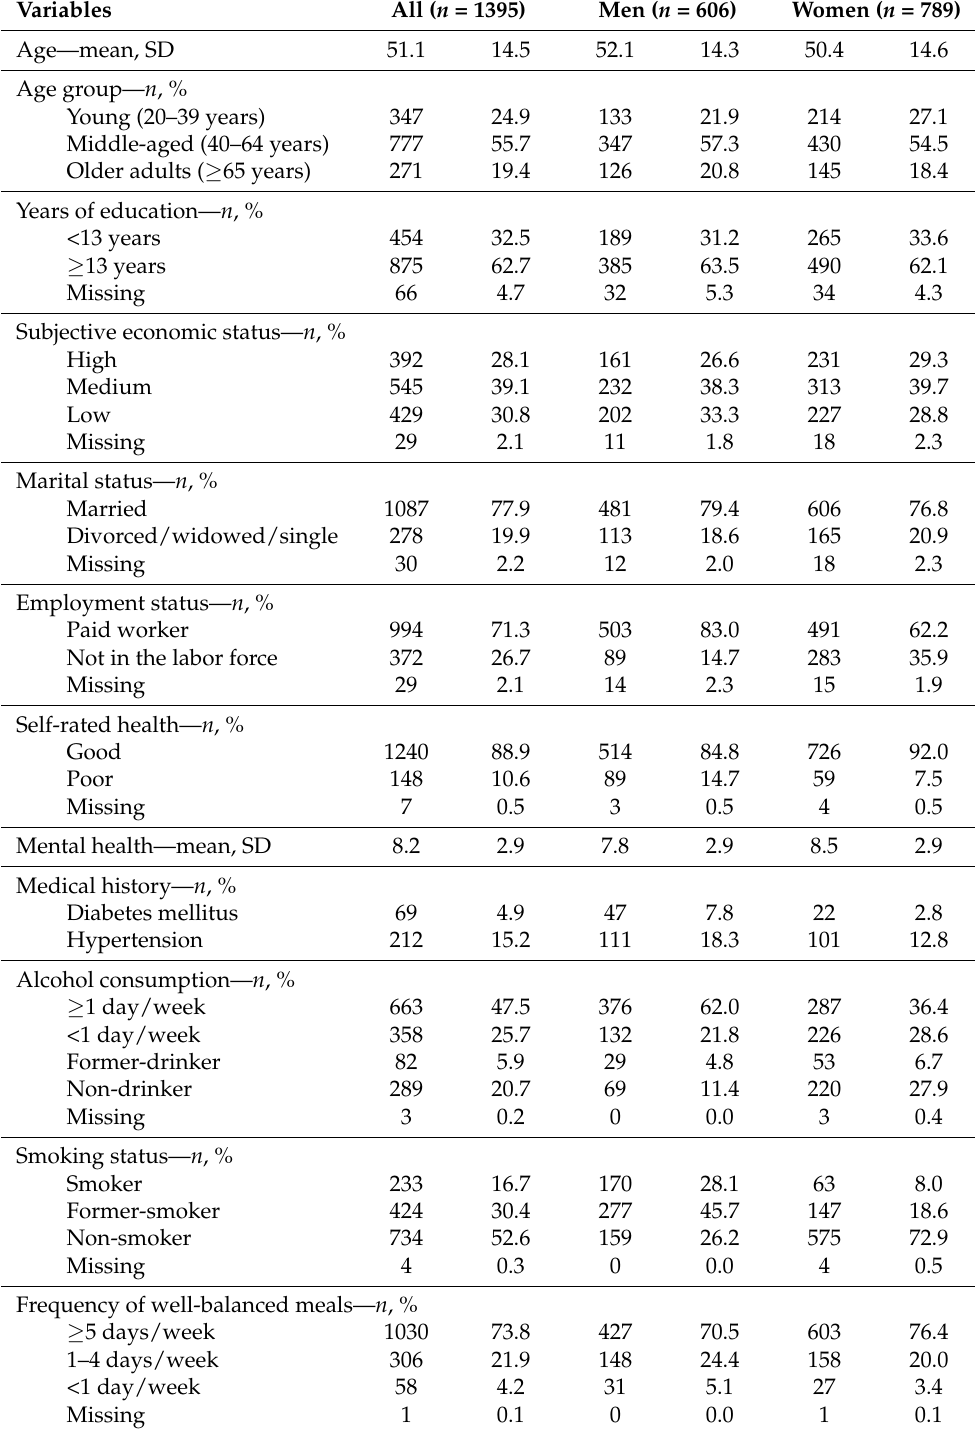
Table 1. Baseline characteristics of the analyzed